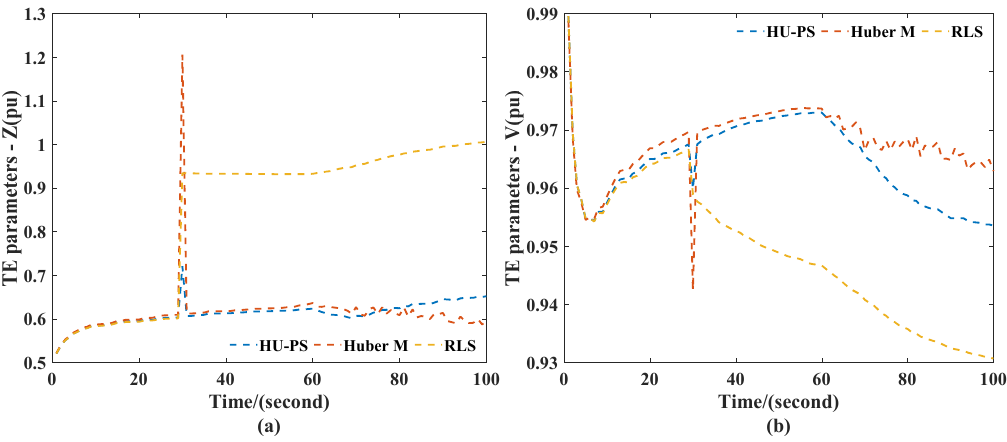
Figure 9. TEPs obtained in case II scenario 1: ( a ) impedance ( b ) voltage.